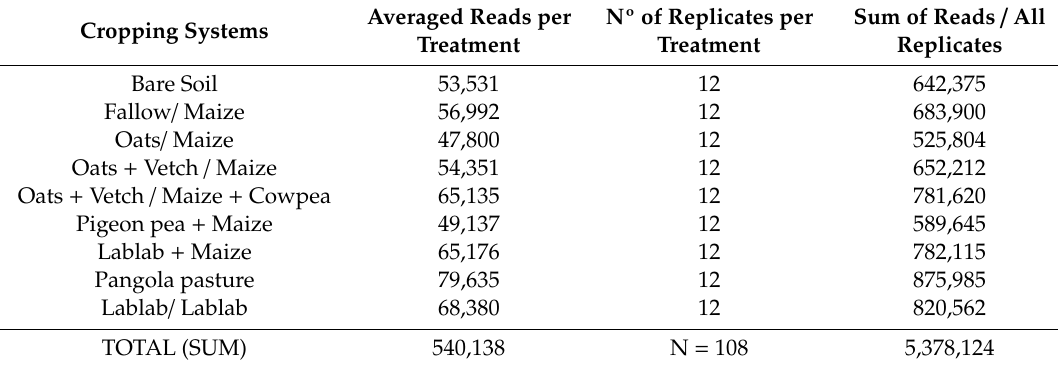
Table 2. Summary of total classified and unclassified DNA reads, and reads at each taxonomic level, detected across nine cropping systems.